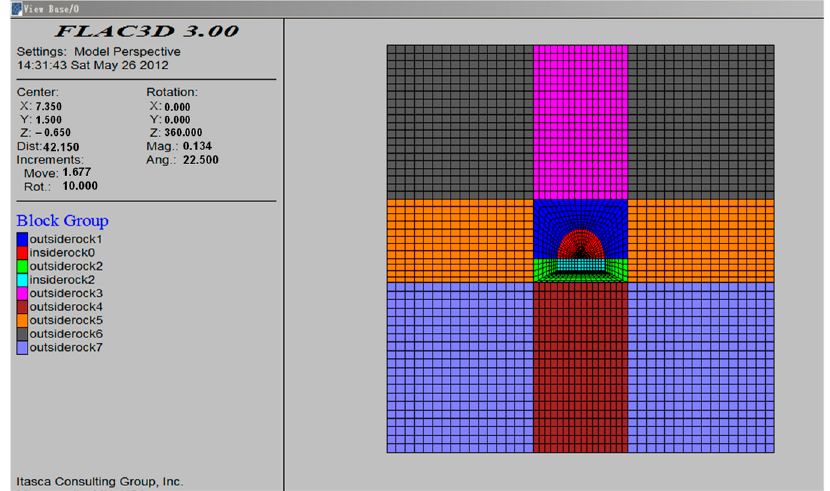
Figure 12. Plane view of finite element model.